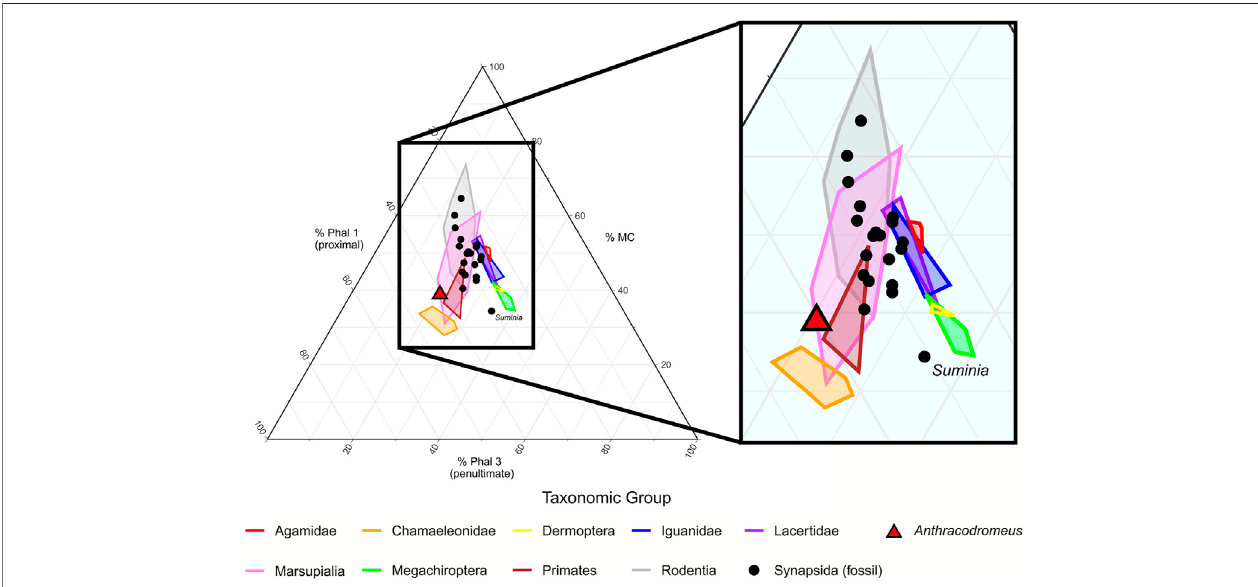
FIGURE3| Ternary plotofthemanual phalangeal proportionsofdigitIIIof Anthracodromeus andtheextantand extinct comparative taxafrom Fröbischand Reisz (2009). Lines represent convex hulls of the different taxonomic groups. MC, metacarpal; Phal 1, phalanx 1; Phal 3, phalanx 3.